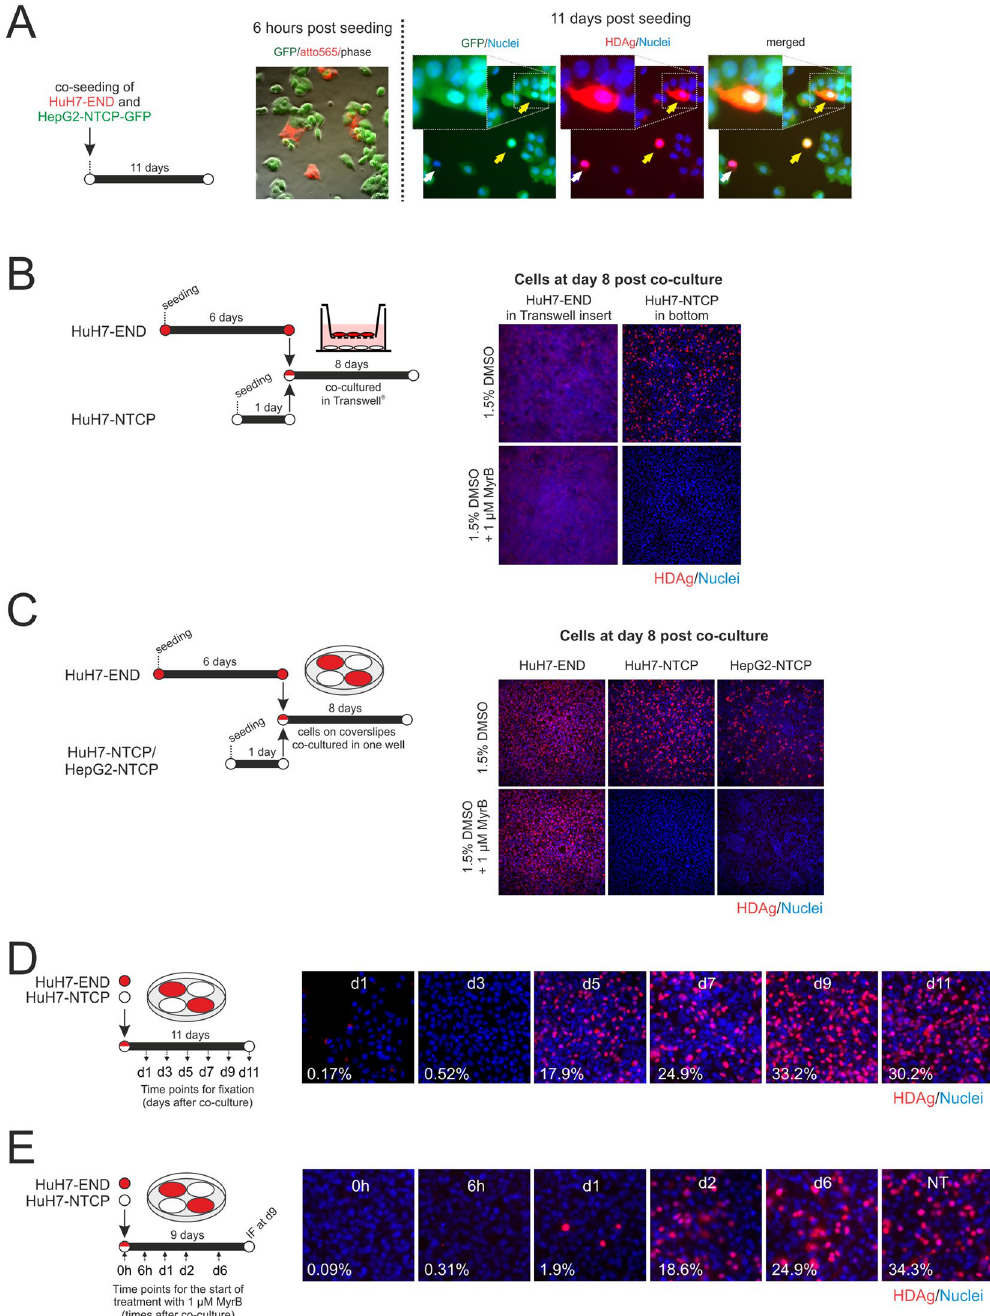
Figure 4. Spread of HDV from HuH7-END to susceptible co-cultured cell lines. ( A ) Co-cultivation of HuH7- END and HepG2-NTCP-GFP cells. HuH7-END cells were temporarily labelled via binding of Atto565-MyrB with NTCP and subsequently co-seeded with HepG2-NTCP-GFP cells (ratio 1:6). 6 hours post seeding, the two cell populations were visualized by GFP fluorescence (green identifying HepG2-NTCP-GFP cells) and Atto565-MyrB fluorescence (red identifying HuH7-END cells). 11 days post co-culture, cells were fixed and stained for HDAg (red) and GFP (green). Cells positive for HDAg (red) identify HuH7-END producer cells (white arrow) while cells positive for both HDAg and GFP (yellow arrows) are infected HepG2-NTCP-GFP cells (zoon-in picture on upper left), indicating that spread occurred. ( B ) Co-cultivation of HuH7-END cells with HuH7-NTCP in Transwell plate. HuH7-END cells grown in a Transwell insert for 6 days were co-cultured with HuH7-NTCP cells seeded on the bottom of well. Medium supplemented with entry inhibitor MyrB were used as a control. Eight days after co-culture, cells were stained for HDAg (red) and nuclei is counterstained by Hoechst (blue). ( C ) Co-cultivation of HuH7-END cells with HuH7-NTCP or HepG2-NTCP cells in coverslips. HuH7-END cells (seeded on coverslips for 6 days) and HuH7-NTCP or HepG2-NTCP cells (seeded on coverslips for 1 day) were co-cultured (left panels) in the presence or absence of the entry inhibitor MyrB. Eight days after co-culture, cells in coverslips were stained for HDAg (red) and nuclei is counterstained by